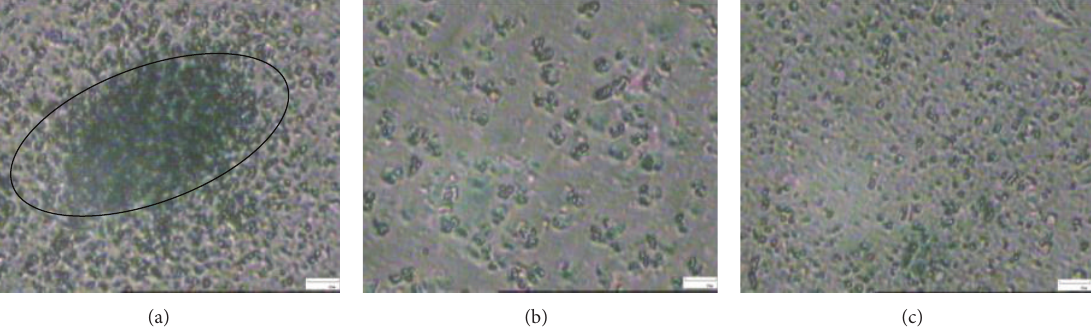
Figure 2: The optical microscope images of PANI/PVA composite membranes with the stirring speed of (a) 1000 rpm; (b) 1600rpm; and (c) 2200 rpm.